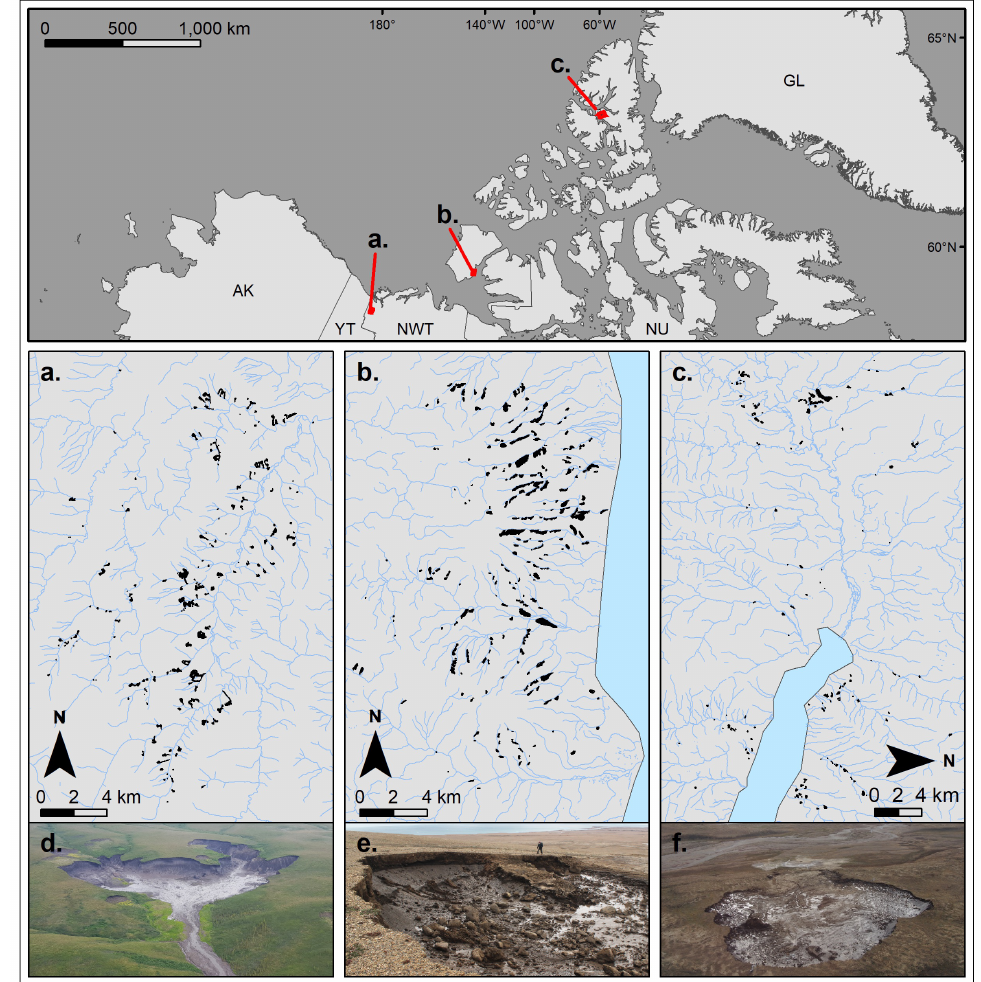
Figure 1. Map of the study area showing thaw slumps used as training data. ( a ) Willow River (WR) Area in the Foothills of the Richardson Mountains, ( b ) the Jesse Moraine (JM) on Eastern Banks Island, and ( c ) the Fosheim Peninsula (FP). The Oblique images in the bottom row show individual slumps in each area: ( d ) Willow River (Photo: Ashley Rudy), ( e ) Jesse Moraine (Photo: Ashley Rudy), and ( f ) the Fosheim Peninsula (Photo: Alison